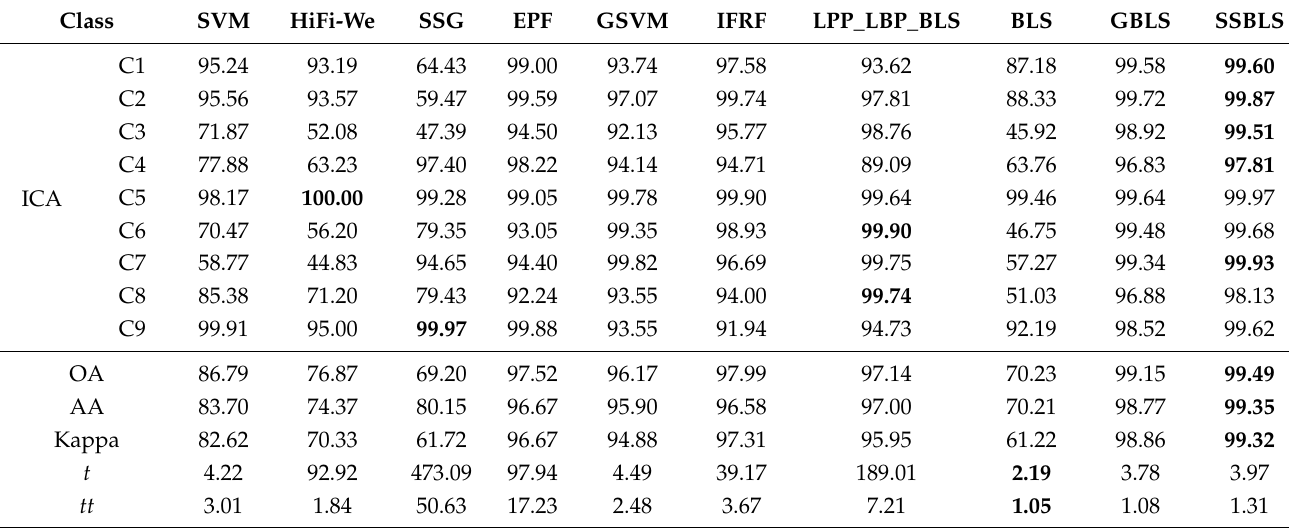
Table 5. Classification results of all comparison methods on the Pavia University dataset in term of individual classification accuracy, ICA (%), overall accuracy, OA (%), average accuracy, AA (%), kappa coefficient, Kappa (%), overall consumed time, t (s), and test time, tt